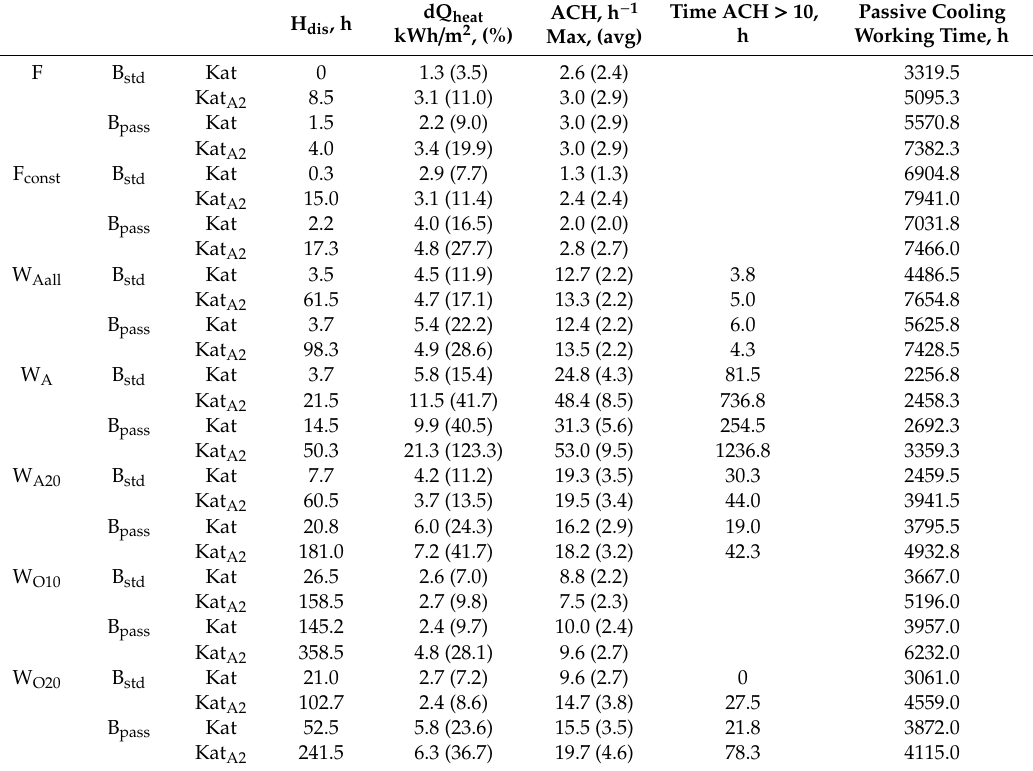
Table 4. Results for the solution with the smallest H dis